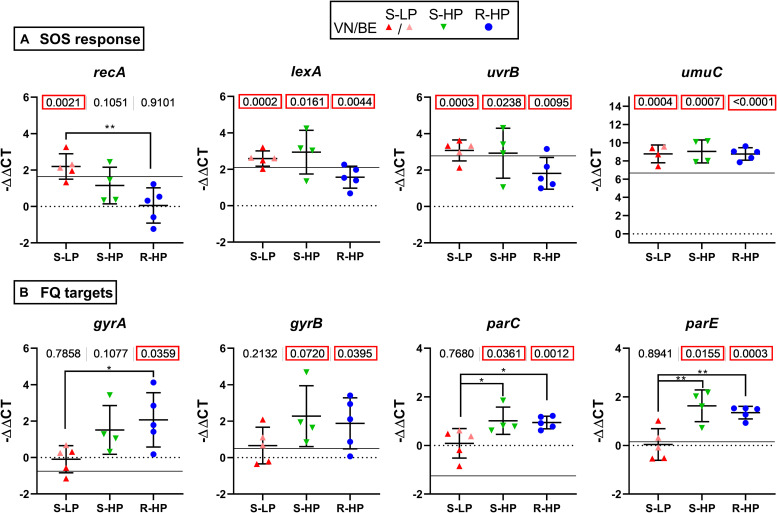
Gene expression and influence of moxifloxacin. Expression of genes encoding proteins involved in SOS response (A) or fluoroquinolone targets (B) in bacteria incubated for 5 h with moxifloxacin at 100 × MIC in the conditions used for performing the persister assay. Data are for selected isolates with susceptible low-persister [S-LP, red (30337, 69474, and 69687)], susceptible high-persister [S-HP, green (69505, 69783, and 69867)], or resistant high-persister [R-HP, blue (30462, 69781, 30566, 13890, and 35994)] phenotypes. Each dot represents one isolate (mean value of triplicates), with the global mean and SD. Data are expressed as −ΔΔCT, with the value of ATCC 25923 at time 0 h used as a reference (horizontal dotted line). The thin horizontal line shows the expression level measured for ATCC 25923 at 5 h. Statistical analysis: the figures at the top of the graphs shows the p value of a t-test comparing the group of isolates with ATCC 25923 at time 0 h. p values lower than 0.05 are squared in red. Stars highlight differences among subgroups by ANOVA analysis (Tukey post hoc test): *p < 0.05; **p < 0.01.